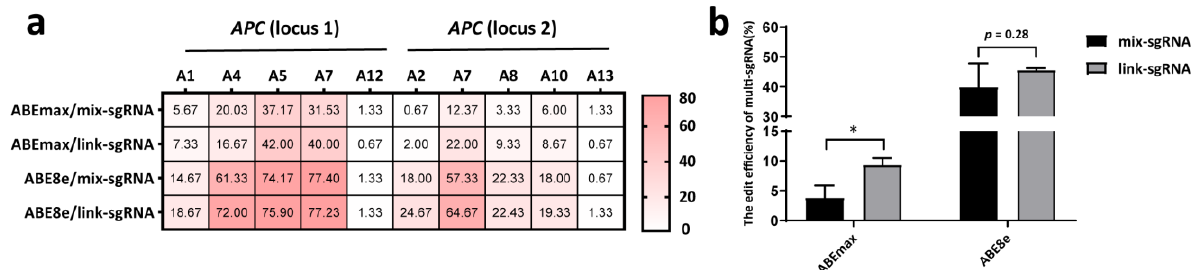
Figure 4. Simultaneous A-to-G conversions at two APC loci in the PFFs with the ABEmax and ABE8e editors using the mix-sgRNA and link-sgRNA strategies. ( a ) The heatmap shows the editing efficiencies of each A site at the two targeting loci via the mix-sgRNA and link-sgRNA strategies. ( b ) The efficiencies of simultaneously inducing desired A-to-G conversion at both loci via the mix- sgRNA and link-sgRNA strategies. * p < 0.05, n = 3, independent replicates.